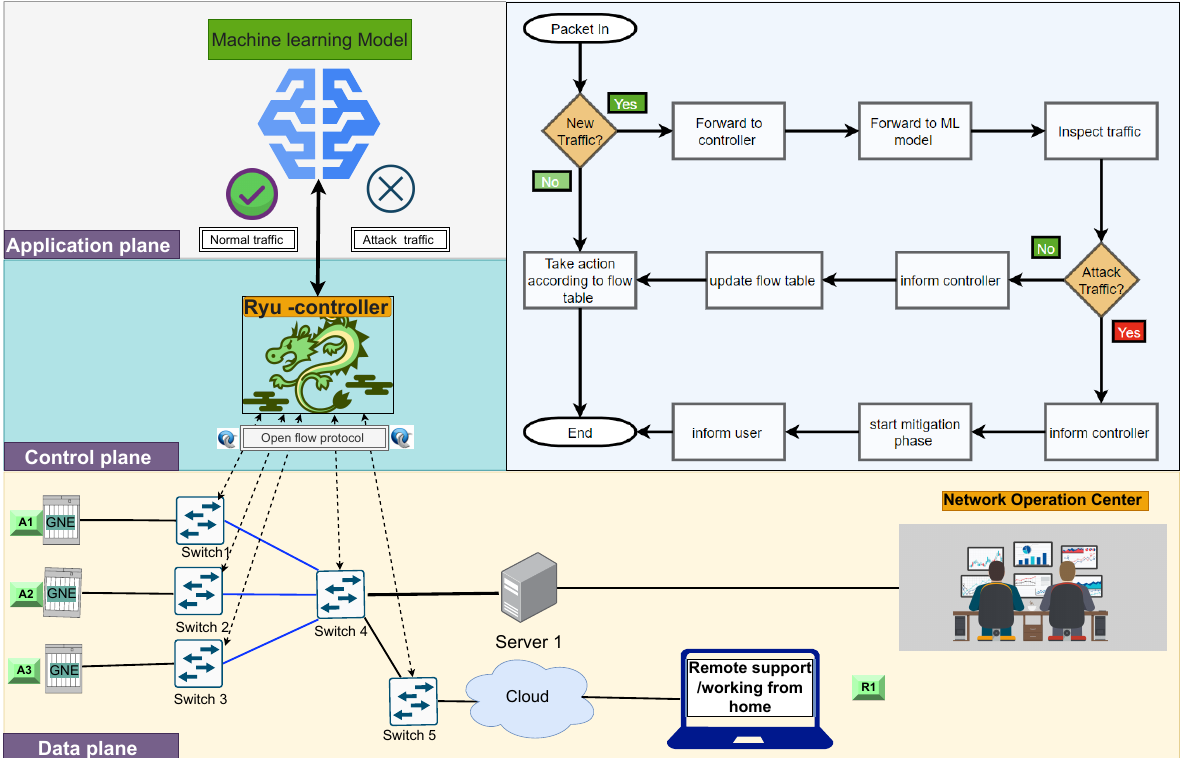
Figure 15. Detection and mitigation